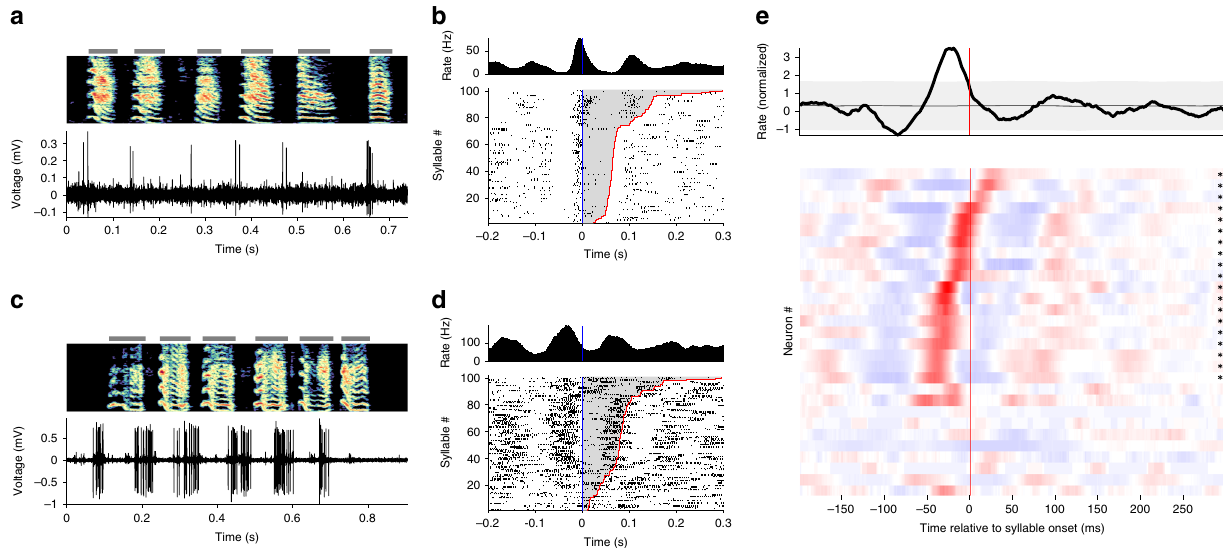
Fig. 2 Onset-related activity in NIf during singing in juvenile birds. a – d Examples of NIf HVC single-neuron activity during singing in juvenile birds. a Song spectrogram (top), and single-unit recording (bottom). Gray bars indicate the extent of each syllable. Here and elsewhere, the vertical axis of the spectrogram represents frequencies ranging from 0.5 to 8 kHz. Note the neuron tends to burst at syllable onsets. b Onset-aligned raster and PSTH for neuron at left, sorted by syllable duration. Syllable onset is marked in blue, offset in red, with the duration of each syllable shaded gray. c , d Same as a and b for another putative NIf HVC recorded neuron during singing. Note that this neuron has a longer premotor latency, longer burst durations, and higher fi ring rates. e Summary of all NIf HVC single-unit recordings during singing. The plot at top shows the mean normalized fi ring rate across all neurons, with gray region showing the extremes of a circularly shifted control ( p < 0.01, two-sided comparison). Plotted below is the syllable onset-aligned PSTH for each individual NIf HVC neuron; each row corresponds to the PSTH of a different neuron. PSTHs are normalized by subtracting the mean and dividing by the standard deviation of the PSTH; red indicates values above the mean, blue below the mean. Neurons with a signi fi cant PSTH peak are marked by an asterisk at right ( p < 0.05, one-sided comparison to circularly shifted control, Bonferroni corrected for 29 comparisons). Signi fi cant neurons are sorted by the latency of their peak fi ring rate, and non-signi fi cant neurons are shown at